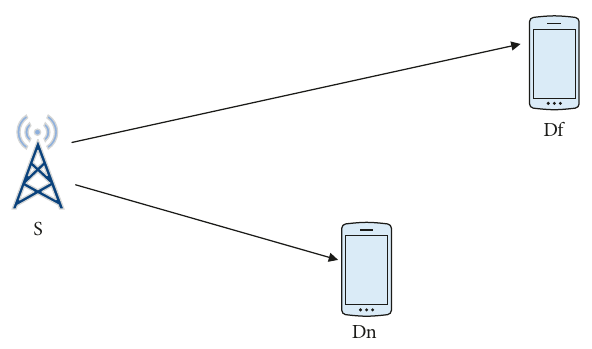
Figure 1: System